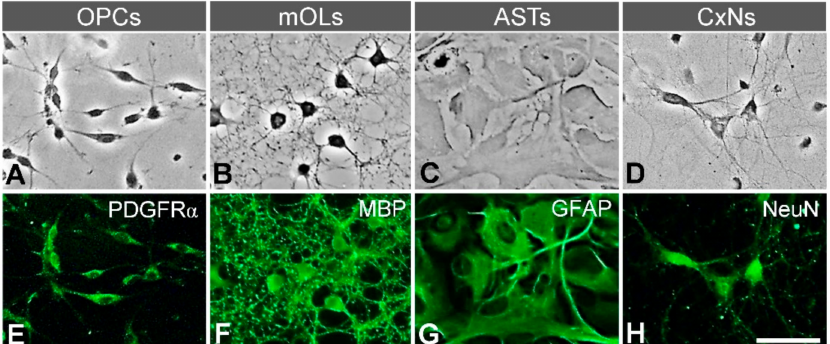
Figure 1. Identification of neural cells isolated from neonate rat brains. ( A – D ) Morphology visualized by phase contrast microscope. Each type—OPCs, mOLs, astrocytes (ASTs), and cortical neurons (CxNs) shows a characteristic shape. ( E – H ) Expression of specific antigens. OPCs, mOLs, ASTs, and CxNs are labeled with anti-PDGFR α , MBP, GFAP, and NeuN antibodies, respectively. Scale bar = 50 µ m.